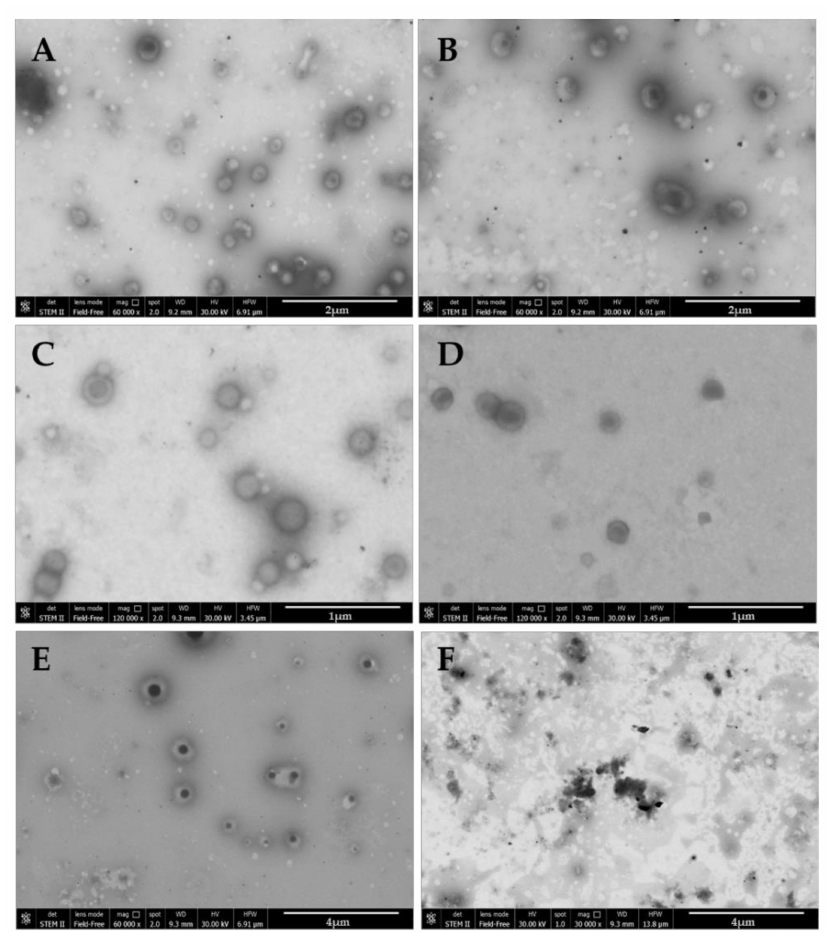
Figure 3. SEM-FEG Nanoparticle images; ( A ) NPs PLGA:Solution0; ( B ) NPs PLGA:Solution1, ( C ) NPs PLGA:Solution2; ( D ) NPs PLGA:Solution3; ( E ) NPs PLGA:Solution4; ( F ) Solution Tween ® 20: β -Glu non-formulated. Note: all formulations contain 5 mg β